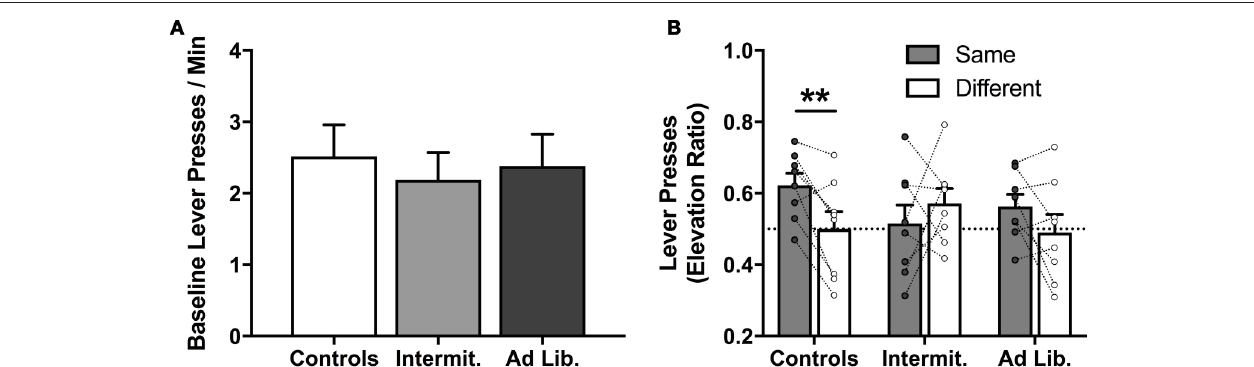
FIGURE 5 | Lever presses during the PIT test. (A) Groups did not differ on pre-cue (baseline) instrumental response rates, suggesting junk-food exposure did not alter general instrumental responding. (B) Lever pressing in response to cues, presented as an elevation ratio from pre-cue responding [cue / (pre-cue + cue)]. Only rats from the Control group successfully used previously learned stimulus-outcome and action-outcome associations to guide action selection, increasing their responding on the “Same” lever significantly more than on the “Different” lever. Means ± SEM, (B) with individual points and repeated-measures lines. ** p < 0.01.